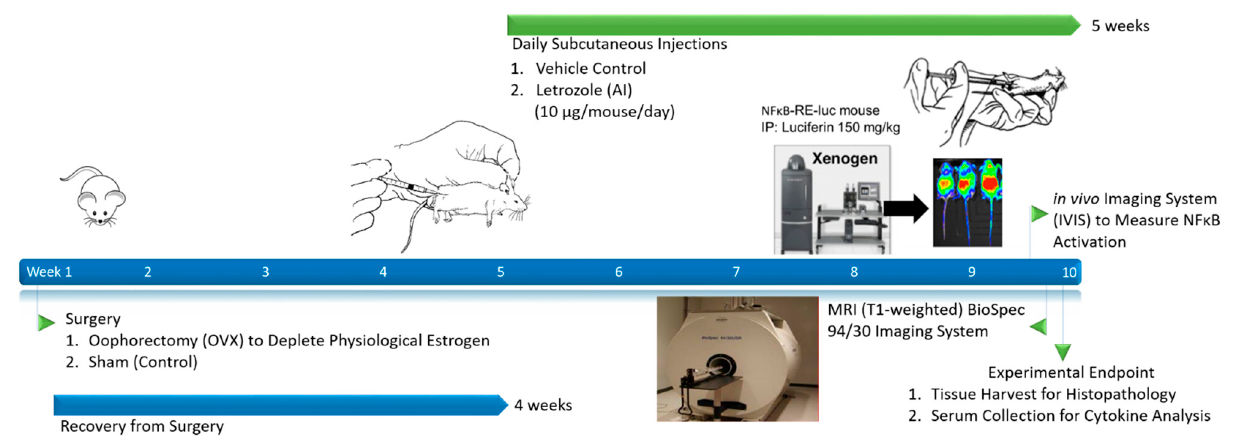
Figure 1. Schematic of experimental outline and sample collection establishing a novel murine model of AIIA.